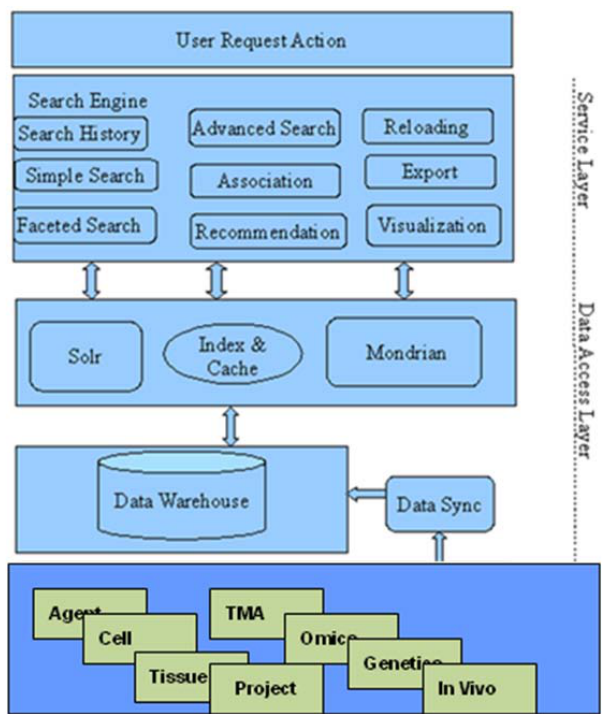
Figure 4: Data integration and query system